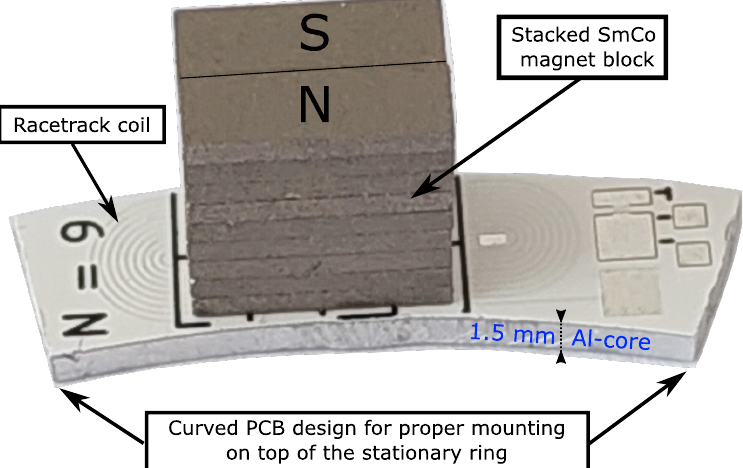
Figure 3. EMAT design for the stationary ring. The curved PCB fits the radius of the stationary ring for edgeless mounting. The racetrack coil consists of 9 turns and a block magnet built of 20 single SmCo magnets is centered with respect to the racetrack coil and glued on top of the PCB. The core of the PCB is formed by a 1.5mm aluminum layer. Within this layer, Lorentz forces are generated, and the mechanical waves are guided into the stationary